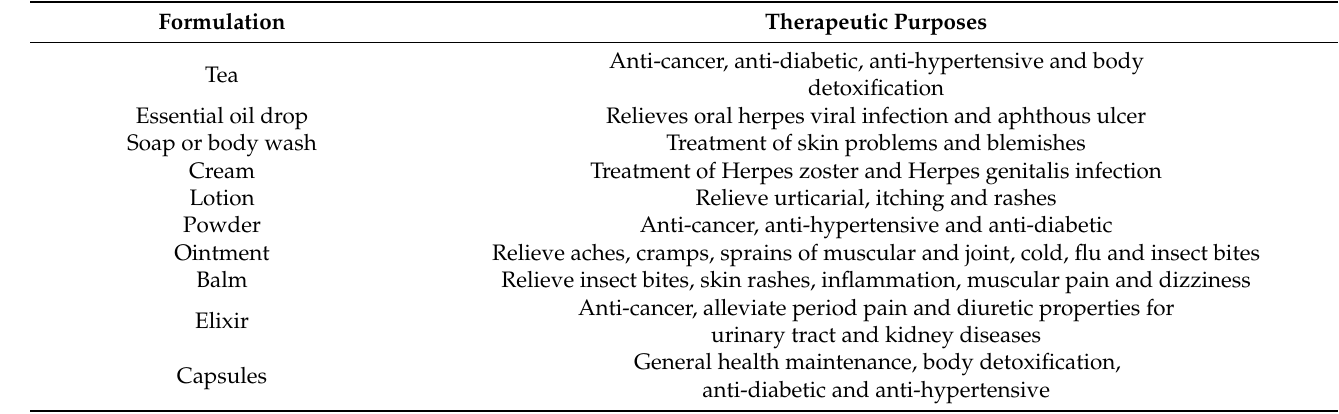
Figure 2. Pharmacological activities of C. nutans . Table 2. A wide variety of commercial products made from C. nutans leaves for traditional and modern